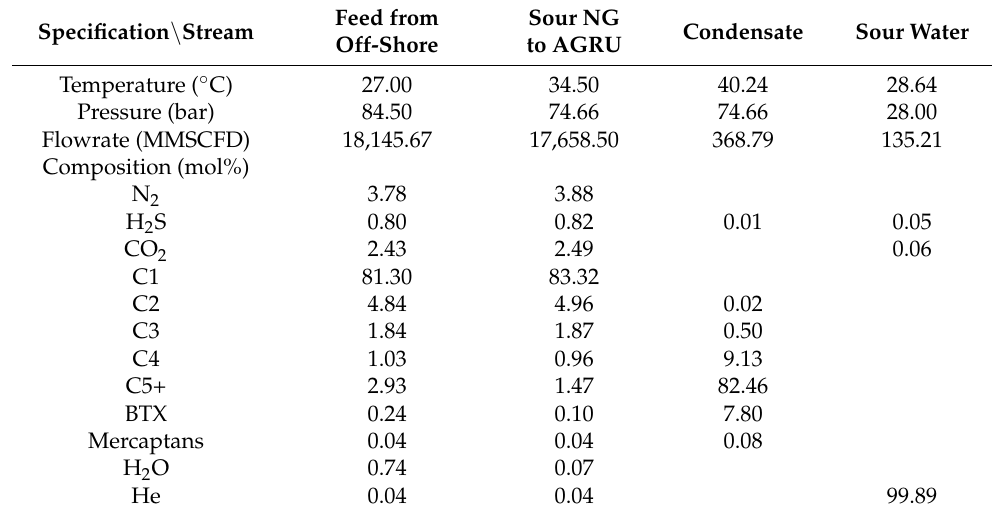
Figure 4. PFD of the simulated preseparation unit. Table 3. Preseparation unit conditions and